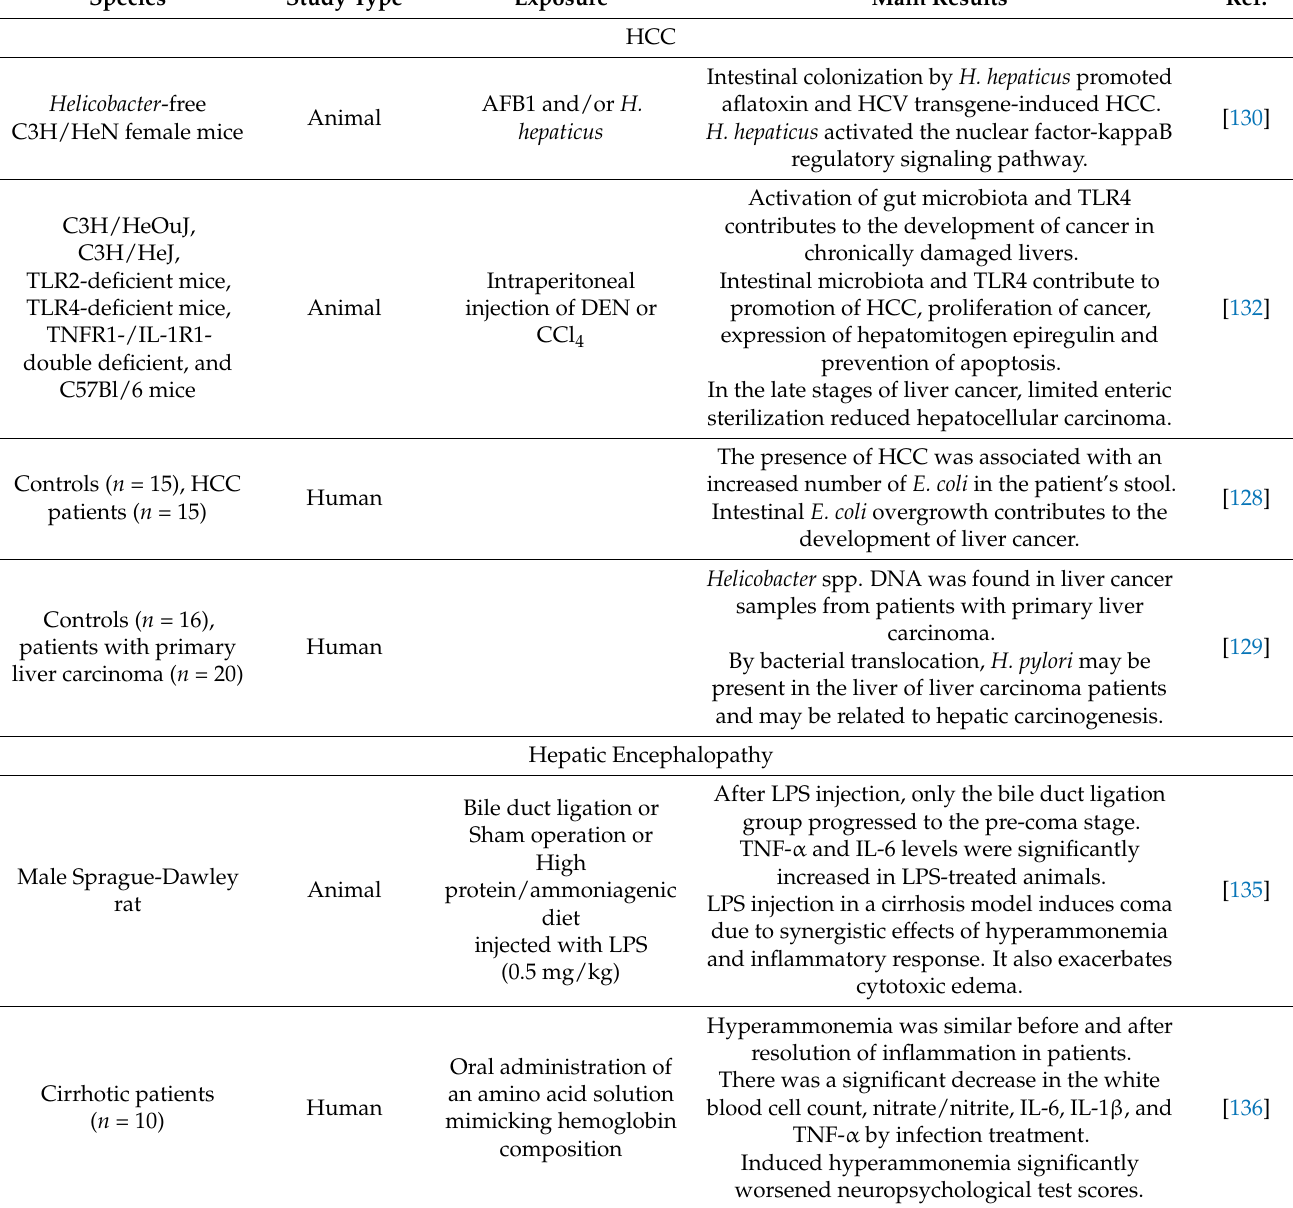
Table 4. Hepatocellular carcinoma and other liver disease studies related to the immune response.